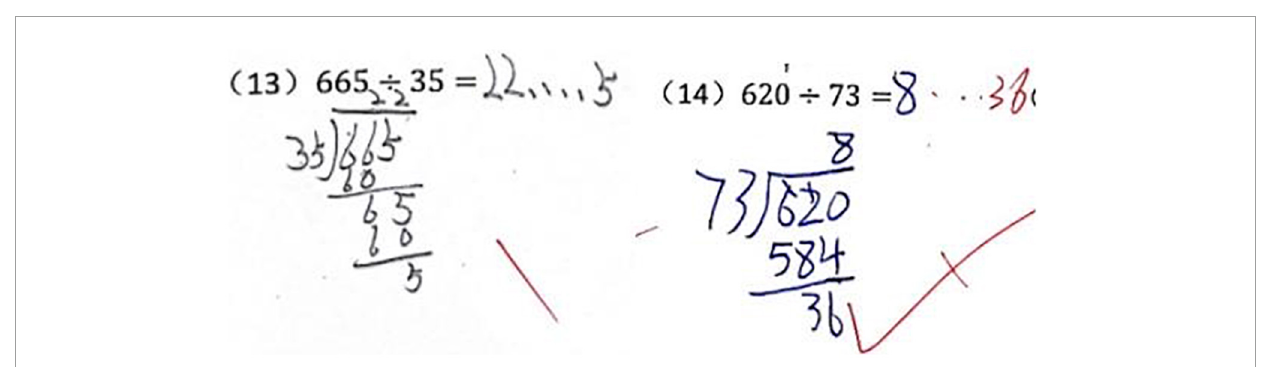
FIGURE6 Confusing division operations for addition, subtraction and multiplication operations, not estimating quotients correctly, missing remainder